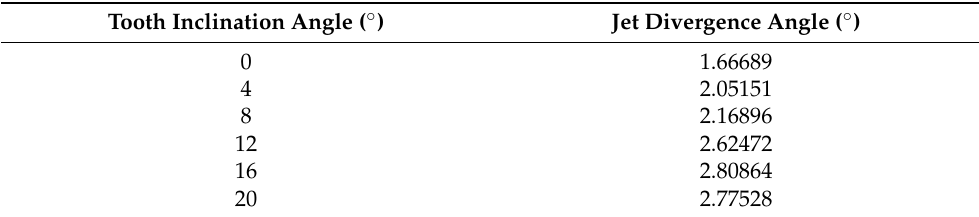
Table 4. Jet divergence angles for several tooth inclination